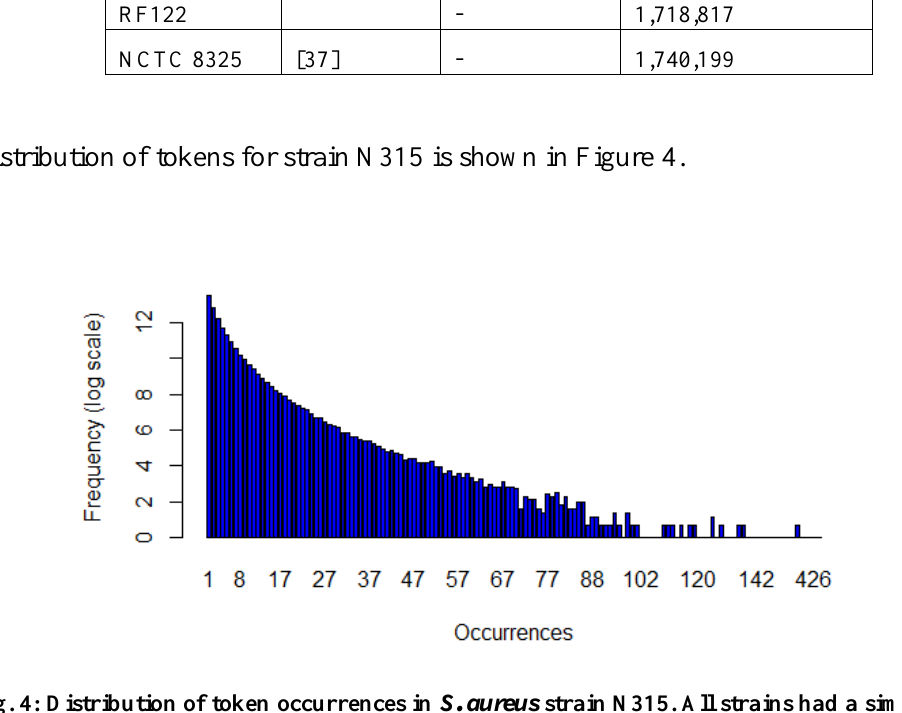
Fig. 4: Distribution of token occurrences in S. aureus strain N315. All strains had a similar token